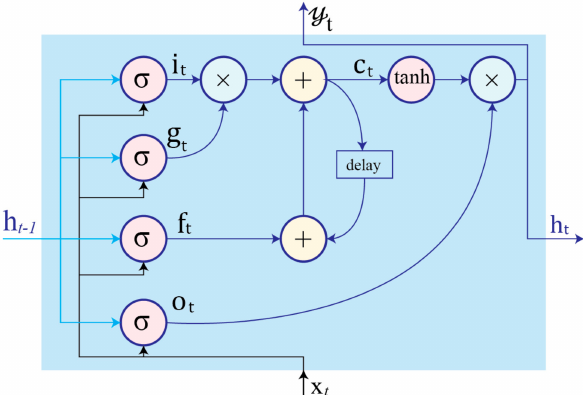
Figure 2. Schematic of LSTM cell structure with an internal recurrence c t and an outer recurrence h t . Cell gates are the input gate i t , input modulation gate g t , forget gate f t , and output gate o t . In